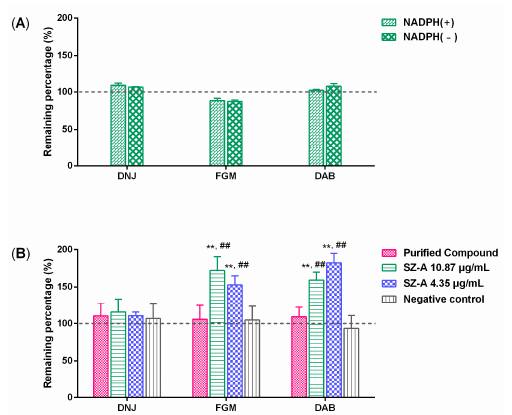
Figure 6. Remaining percentage of DNJ, FGM, and DAB from SZ–A in rat intestinal homogenate ( A ) and rat caecal microbiota cultures ( B ) ( n = 3). Compared with the purified DNJ group, ** p < 0.01; compared with the negative control group, ## p < 0.01.